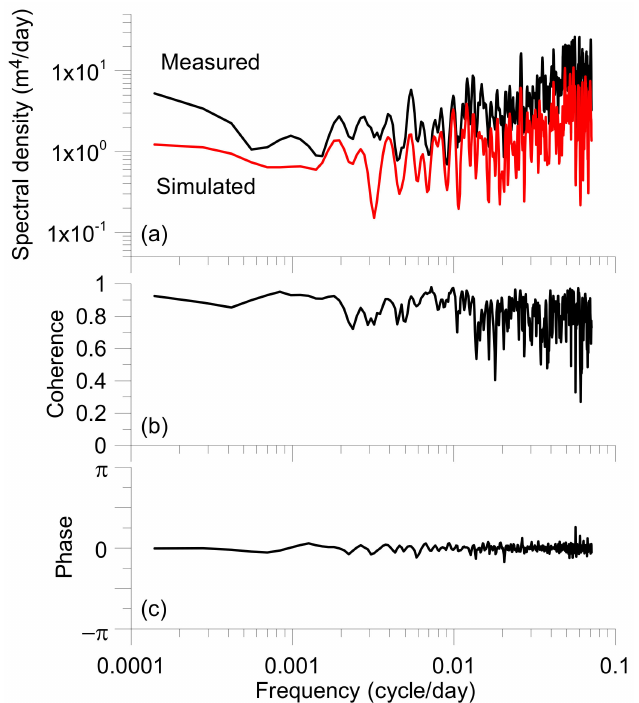
Figure 20. Measured and simulated weekly averaged volume-change rates in the validation process: ( a ) power spectral densities, ( b ) coherence, and ( c )